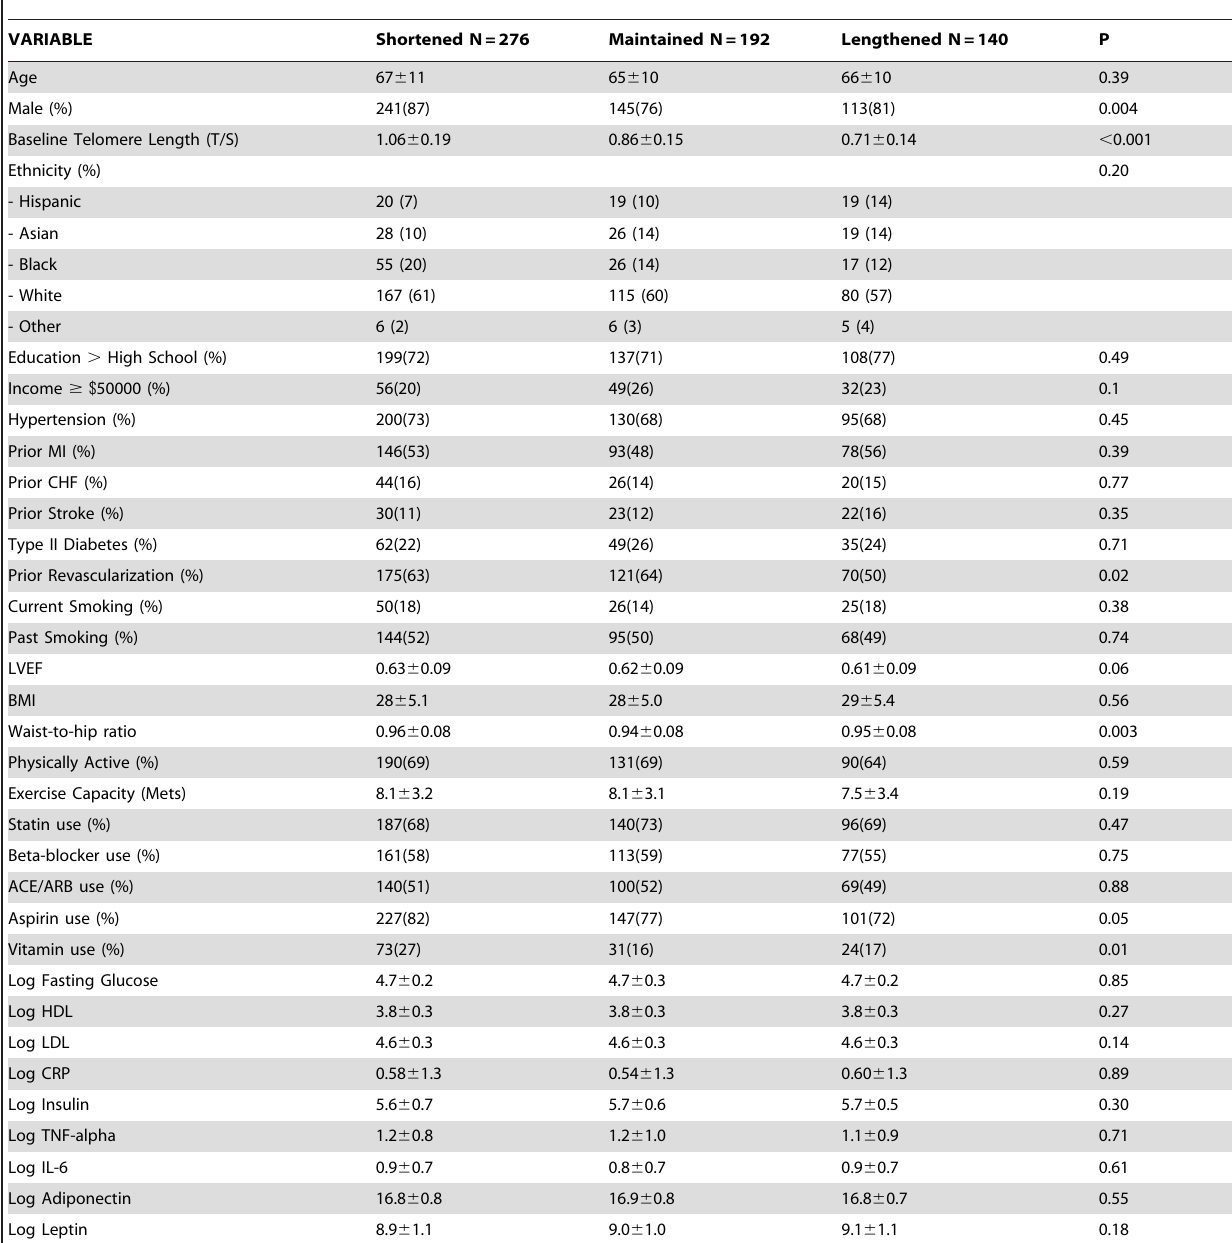
Table 1. Baseline characteristics of study population categorized by trajectory of leukocyte telomere length over five